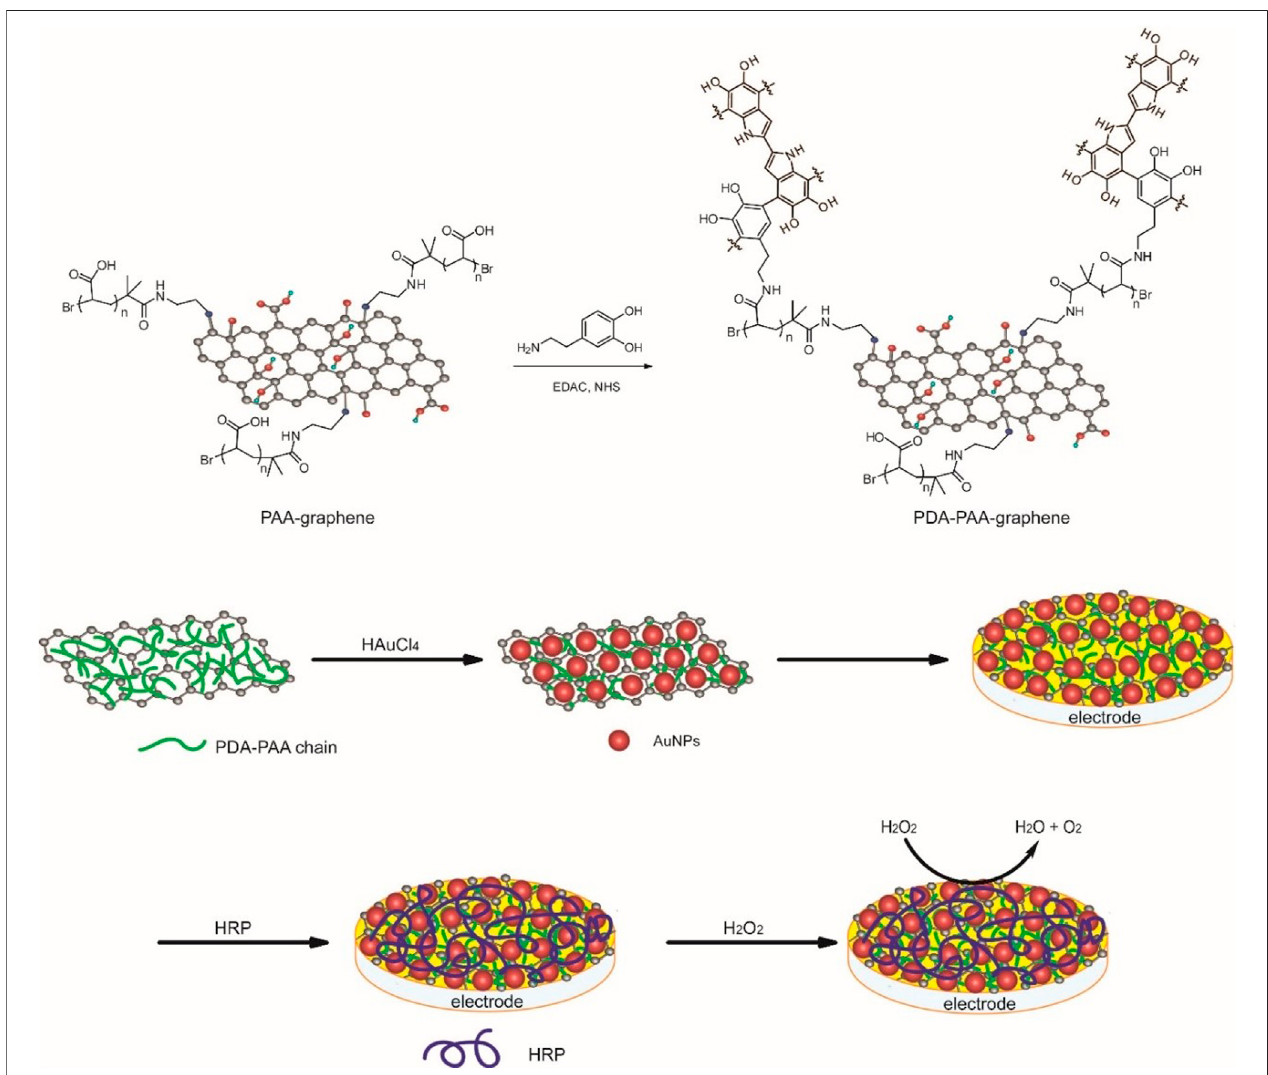
FIGURE 1 | The preparation of the Au NPs-PDA-PAA-graphene composite and the construction of enzyme electrode.